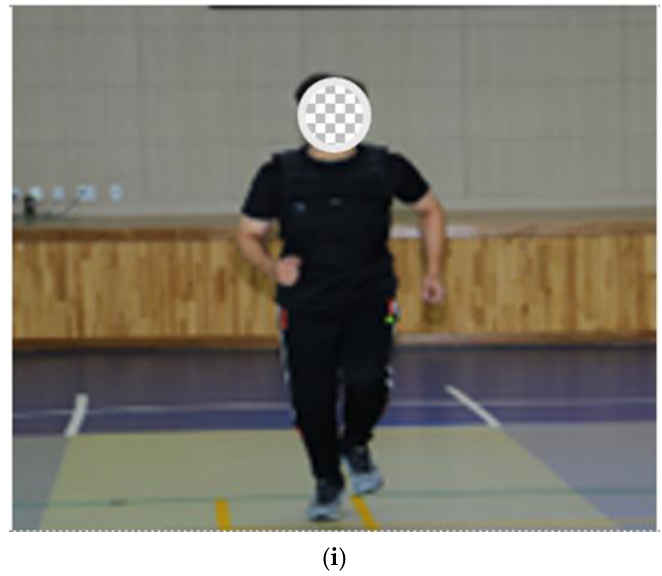
Figure 1. Changed physical fitness test sequence chart. ( a ) Burpee Test; ( b ) Hose drag & Pull; ( c ) Equipment Carry; ( d ) Medicine Ball Throw; ( e ) Inverted Row; ( f ) Sledge Push; ( g )Tunnel get through; ( h ) Victim Drag; ( i ) 400 m Shuttle Run [10].